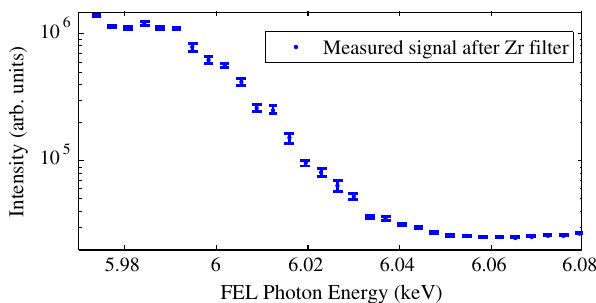
FIG. 6. Plot of measured intensity on the direct imager YAG screen ( y axis) vs photon energy ( x axis), with the FEL tuned to near 6 keV fundamental and the zirconium attenuator inserted. The dropoff in intensity as the fundamental photon energy crosses 6 keV corresponds to the zirconium K edge at 18 keV; we conclude that the drop in intensity is due to third harmonic content. With the zirconium filter blocking the fundamental, we find that the remaining radiation is almost entirely third har- monic. Electron energy jitter and FEL bandwidth broaden the otherwise sharp K edge seen in Fig.